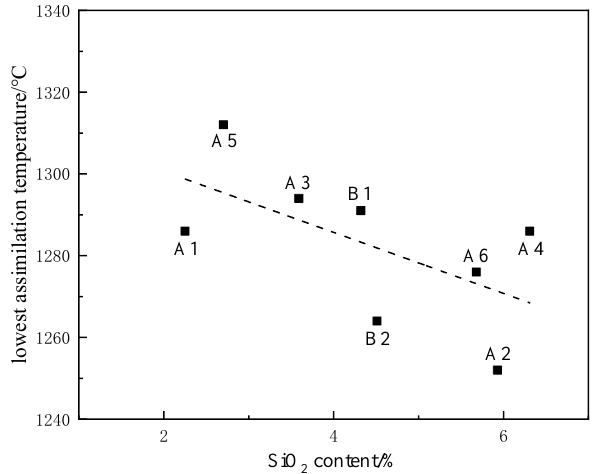
Figure 6. Influence of Al 2 O 3 content on assimilation temperature. It can be seen from Figure 7 that the SiO 2 content in the iron ore powder sample and the assimilation temperature showed a certain regularity. With the increase in SiO 2 content in the iron concentrate powder sample, the assimilation temperature showed a downward trend. During sintering, SiO 2 and Al 2 O 3 are incorporated into binary calcium ferrite to form composite calcium ferrite (SFCA-I or SFCA). With low-silica magnetite as the main ore for high-basicity sintering, an increase in SiO 2 and Al 2 O 3 content promotes the formation of composite calcium ferrite (SFCA-I). In particular, SiO 2 and Al 2 O 3 in the form of clay have high reactivity, which reduces the minimum assimilation temperature [19,20]. The relationship between the SiO 2 content of all iron ore powders and the assimilation temperature was analyzed as a whole. When ore blending was optimized in the experiment, when the SiO 2 content of iron ore powder was lower than 6.0%, increasing the SiO 2 content was conducive to reducing the assimilation temperature.